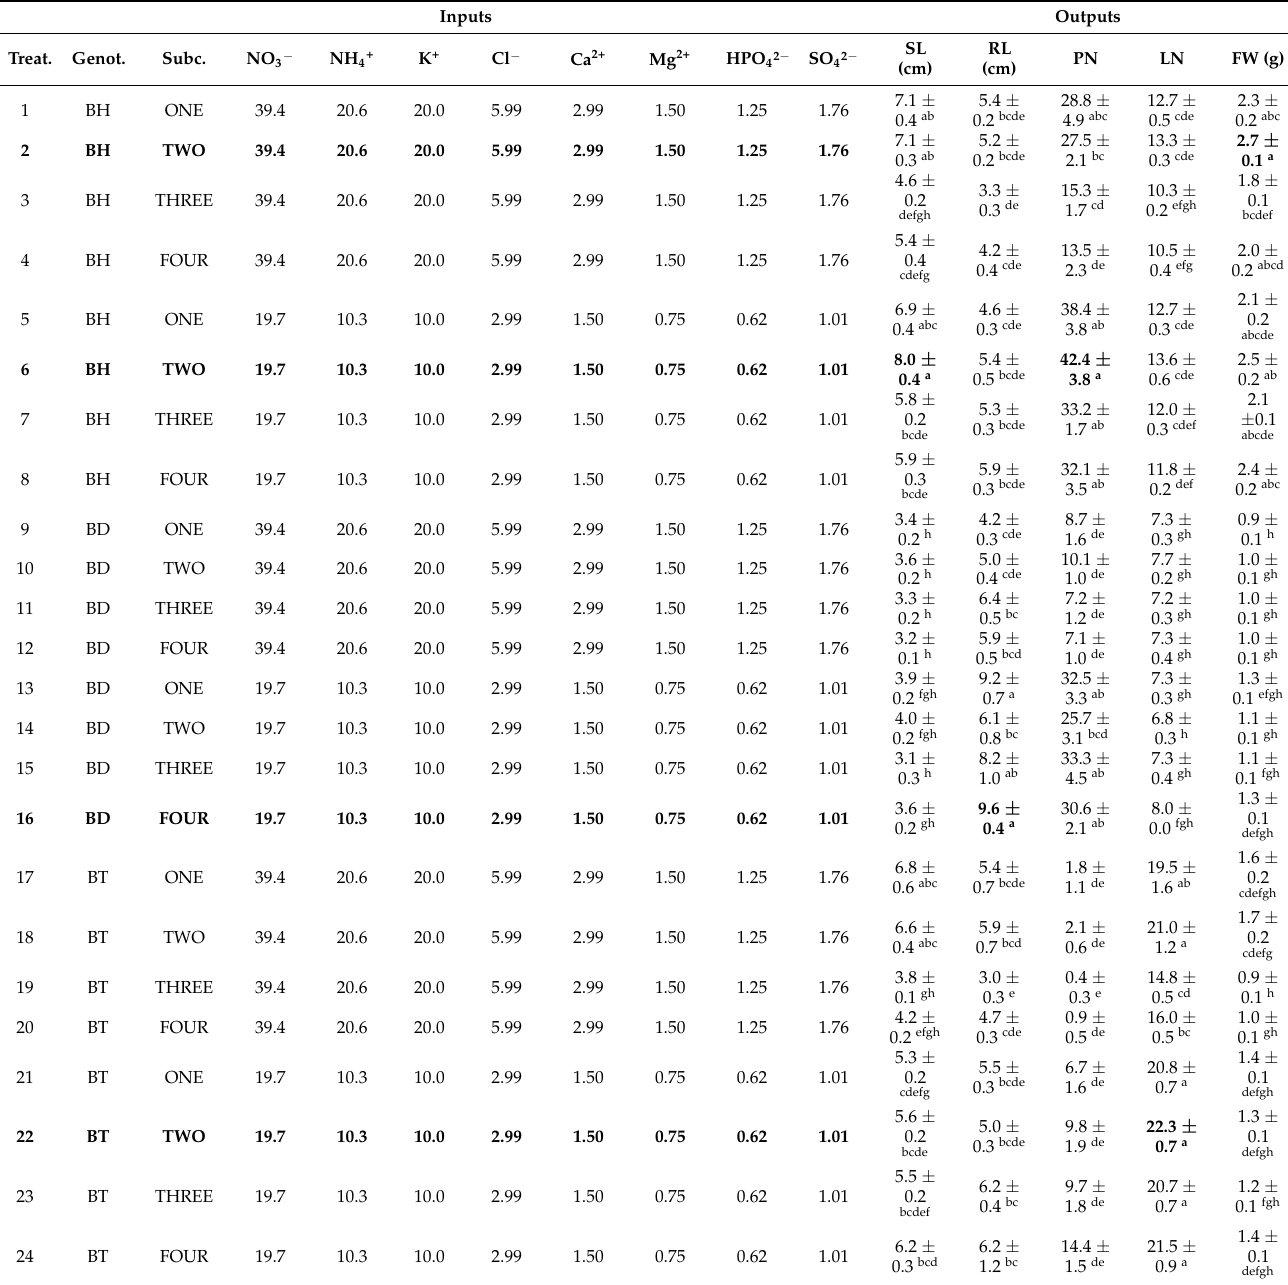
Table 1. Inputs (genotype: genot.; subculture number; subc.; and ion concentration in mM) and outputs (SL, RL, PN, LN, and FW) used for ANN modeling. Outputs are expressed as the mean ± standard deviation. Bold letters indicate maximum values for each treatment (treat.). Differ- ent letters in the same column indicate significant differences ( p < 0.005). Different super-script letters in the same column indicate significant differences ( p <